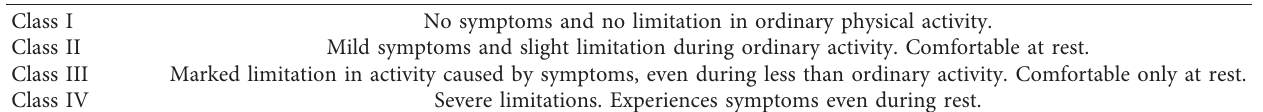
Table 4: New York Heart Association’s classification of CHF